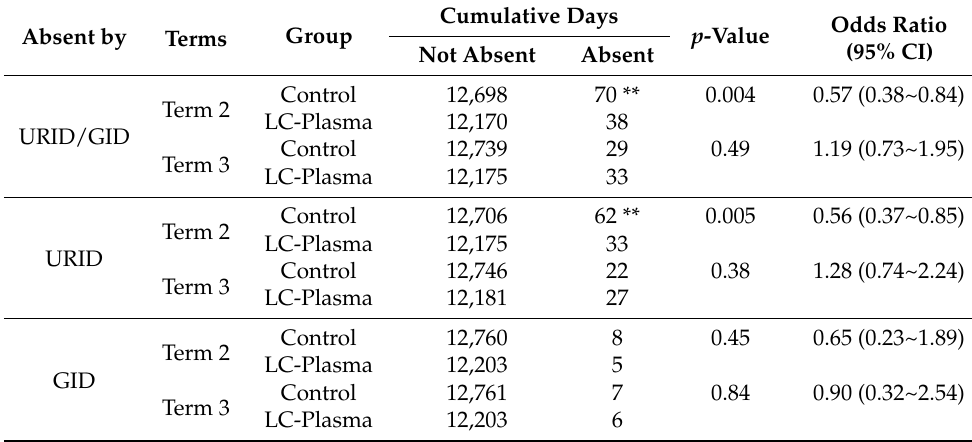
Chi -square test is used for statistical analysis. p -value and odds ratio and its 95% confidence interval (CI) are shown. ** represents significant difference between Control and LC-Plasma ( p < 0.01). URID represents upper respiratory infectious disease, and GID represents gastrointestinal infectious disease.